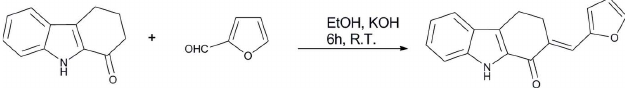
Figure 5 Synthesis of the title